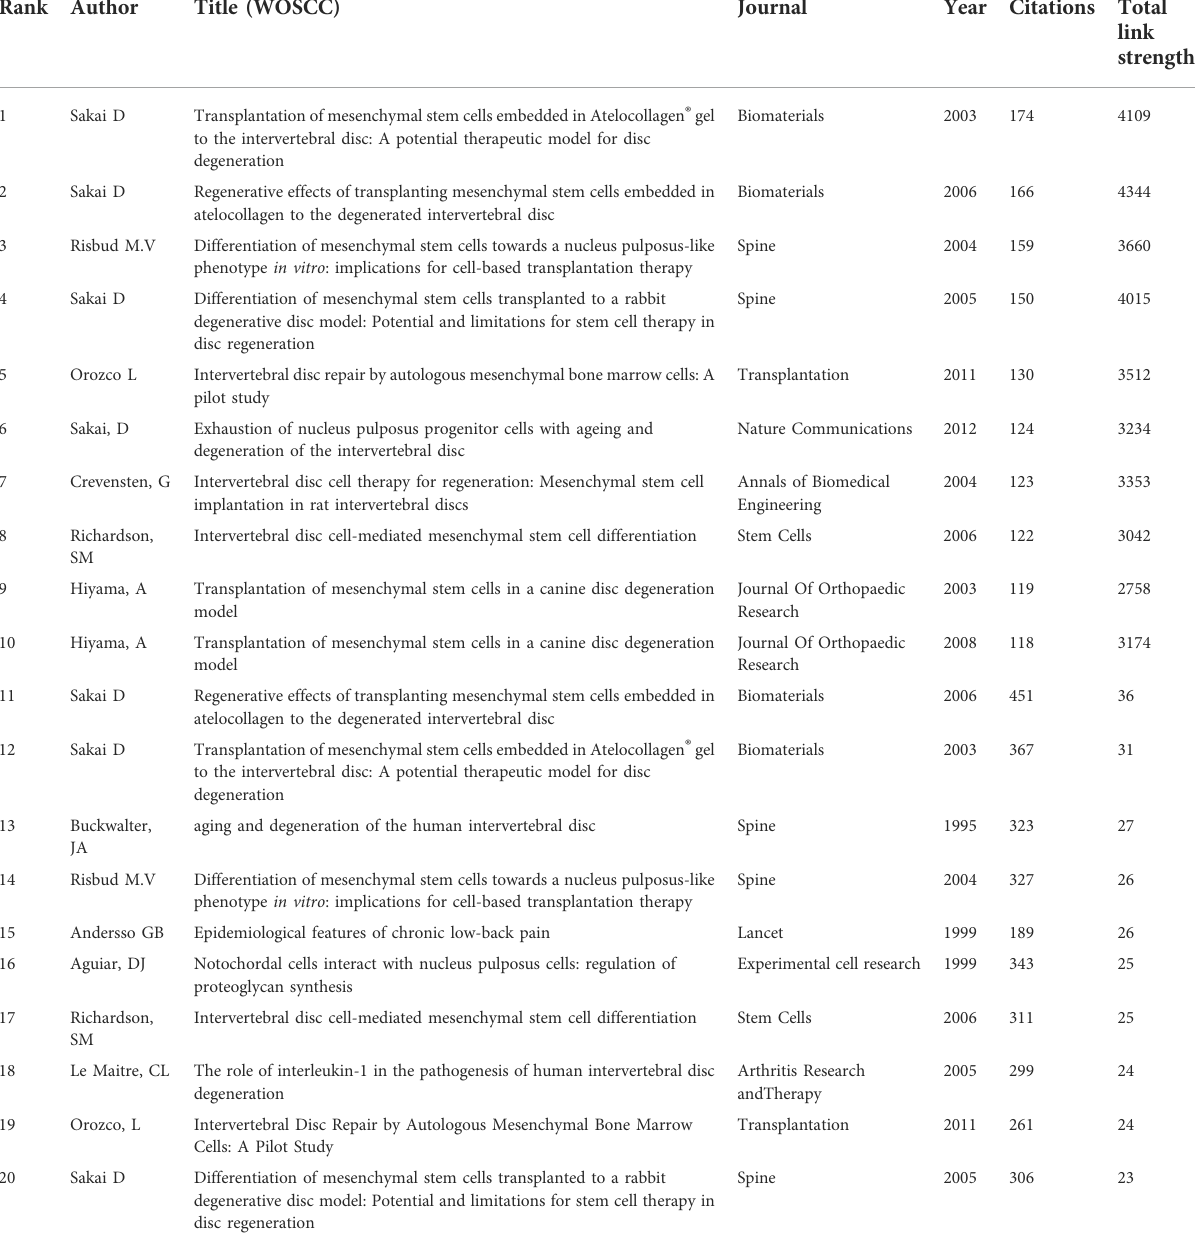
TABLE 5 Top 10 Co-Citation articles in the WOSCC and Scoups